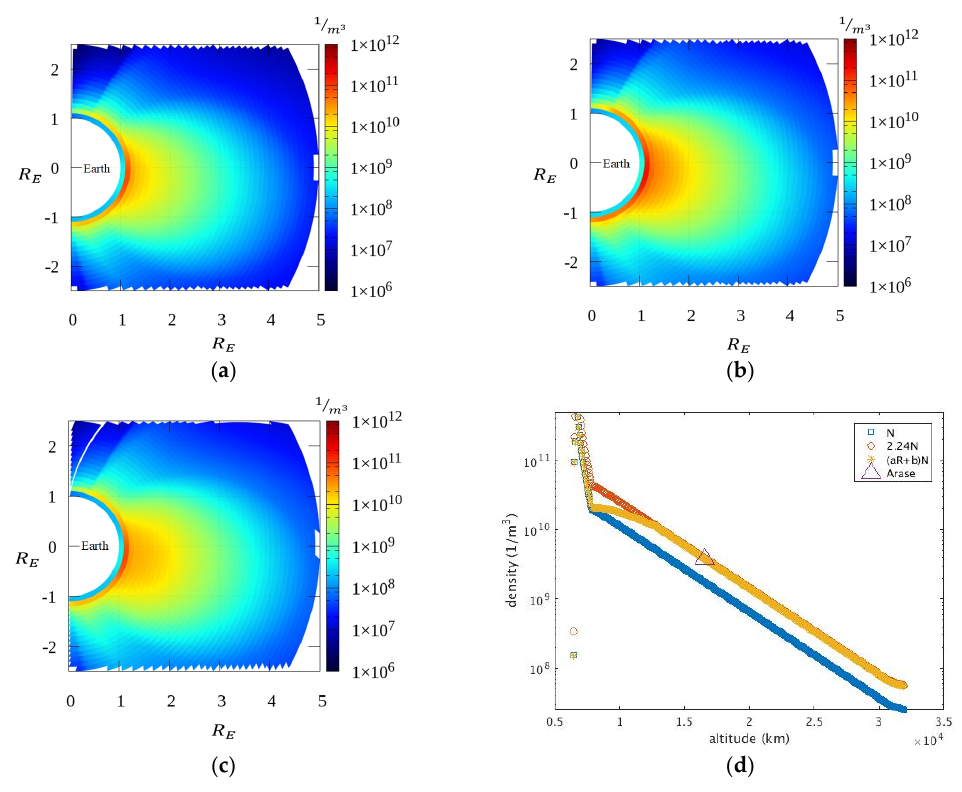
Figure 9. The generated electron density profiles at longitudinal 120 ◦ : ( a ) without modification; ( b ) modified by f ( r ) = c ; ( c ) modified by Function 6. ( d ) The reference electron density without and with modification at the geographic coordinate of longitude 120 ◦ and latitude 9 ◦ We calculated the ray path using these electron density profiles for all frequency ranges. This simulation can provide information on the direction, intensity, and time of arrival of the rays at different points in three dimensions. To see how the ray path passes the satellite position, we plotted the ray path in two dimension for a particular slice at longitudinal 120° as shown in Figure 10a–c. This shows the electron density profile in color contours and the ray paths at 5 kHz, 8 kHz, and 10 kHz under the modified electron density profile using Equation (6). The purple line describes the ray paths, and the black triangle indicates the location of the Arase. The different frequencies of the ray result in slightly different paths.